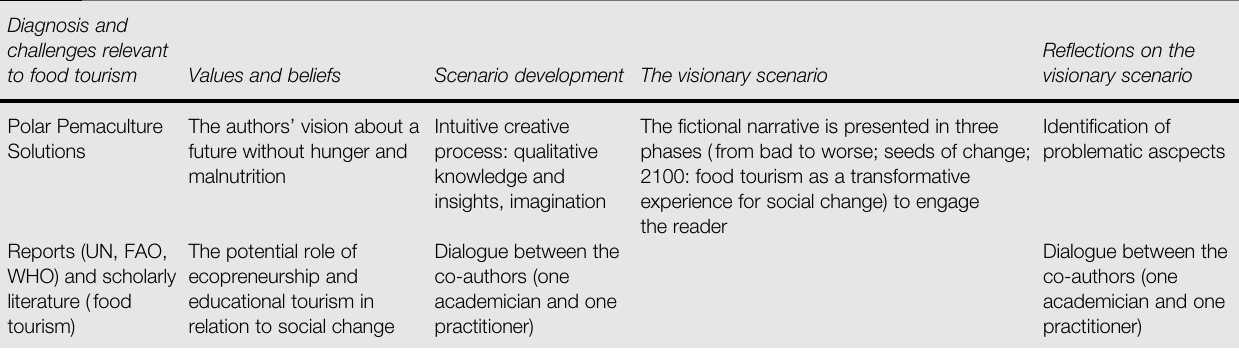
Table I The process of the scenario development Diagnosis